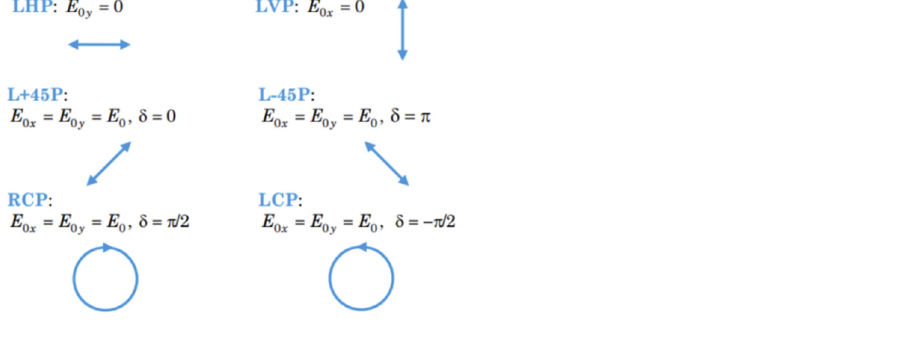
Figure 3. An example of the different polarization states determined by the amplitude ratio and phase shift between two polarization components.